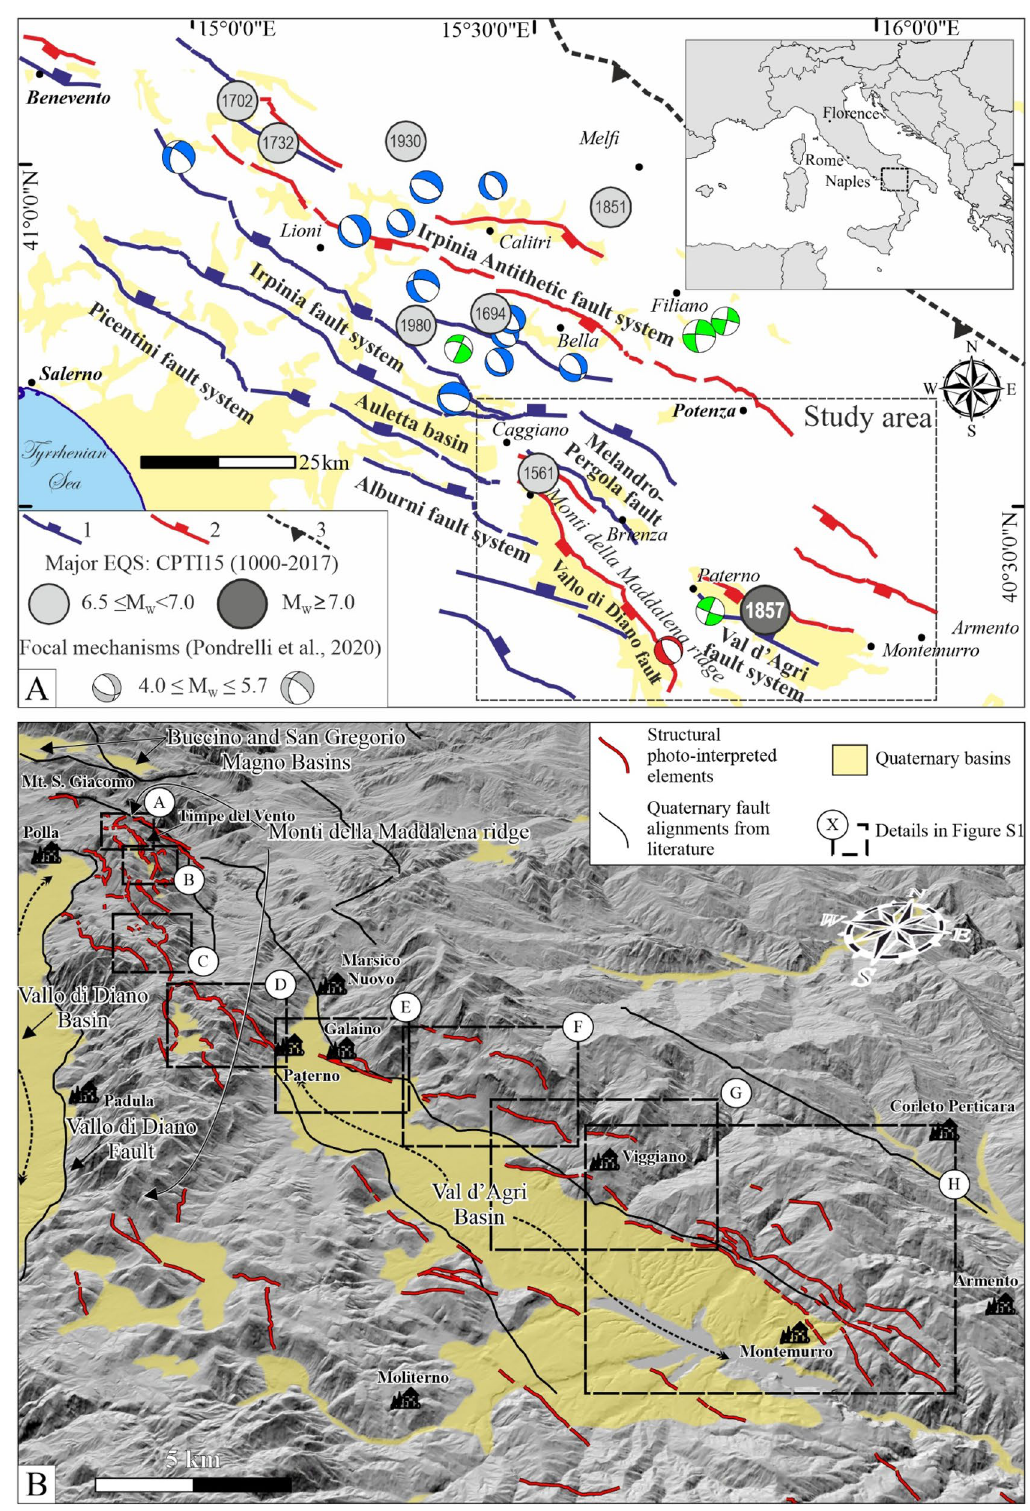
Figure 1. (A) Regional structural map and study area. The major normal fault alignments are from Brozzetti et al. 10 and Bello et al. 9 . Key: 1 = ~ NE-dipping normal faults; 2 = ~ SW-dipping normal faults; 3 = thrust faults. Major historical earthquakes reported as grey circles are from the Parametric Catalogue of Italian Earthquakes, CPTI15 v4.0 5,6 . Earthquake focal mechanisms (0–15 km; 4.3 ≤ M w ≤ 6.8; 1962–2002) are from Pondrelli et al. 4 , divided into blue (normal) and green (strike-slip). The red focal mechanism is from López-Comino et al. 11 . Yellow areas represent Quaternary deposits. (B) Bird’s-eye view map of the photo-interpreted elements. Background is a 10 m hillshaded-DEM 12 . Red lines are the structural elements observed during the preliminary phase of photointerpretation, while black lines are faults from literature. Yellow areas represent Quaternary deposits in-fill. Dashed squares are the details reported in the Figure S1 of the Supplementary Material. Black dotted arrows indicate the Vallo di Diano and Val d’Agri